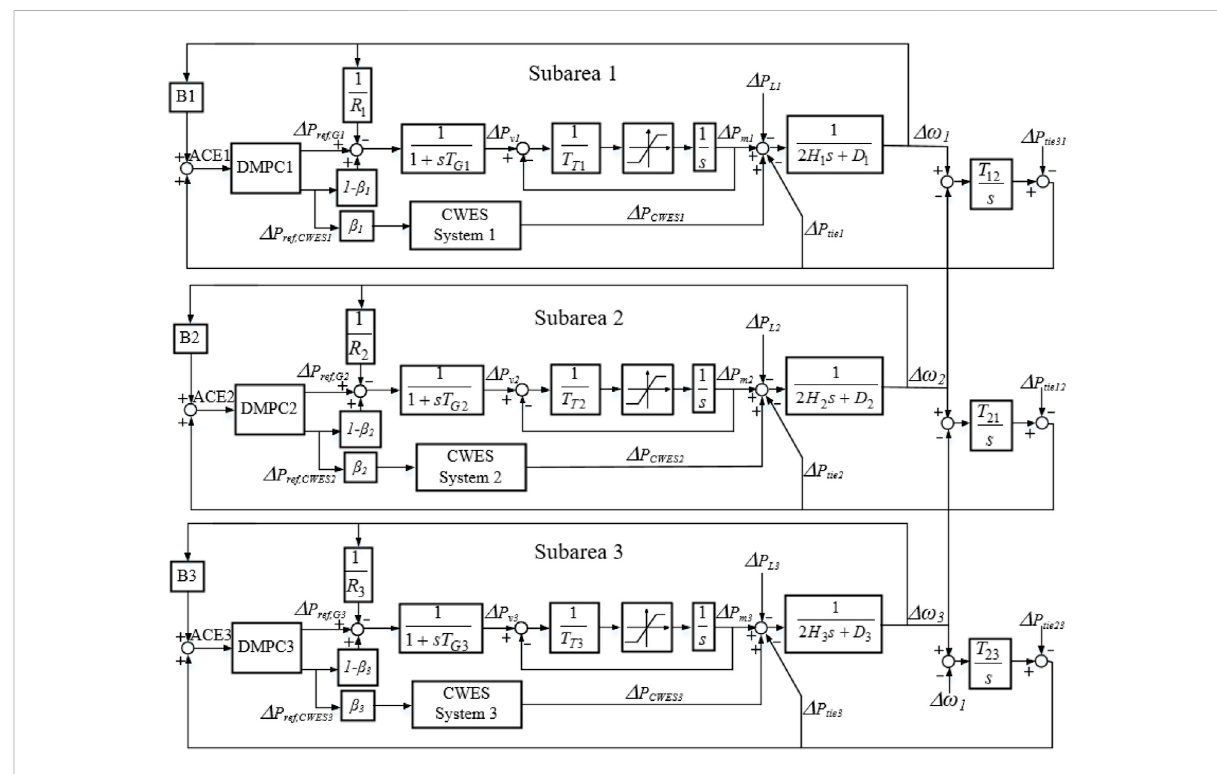
FIGURE 1 Framework of multi-area power system with